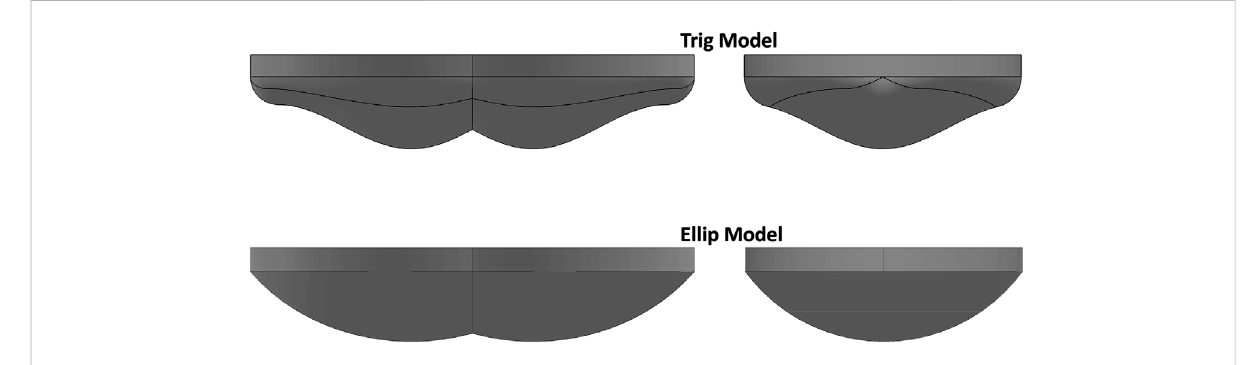
FIGURE 1 Shapes of elliptical and trigonometric elastomer